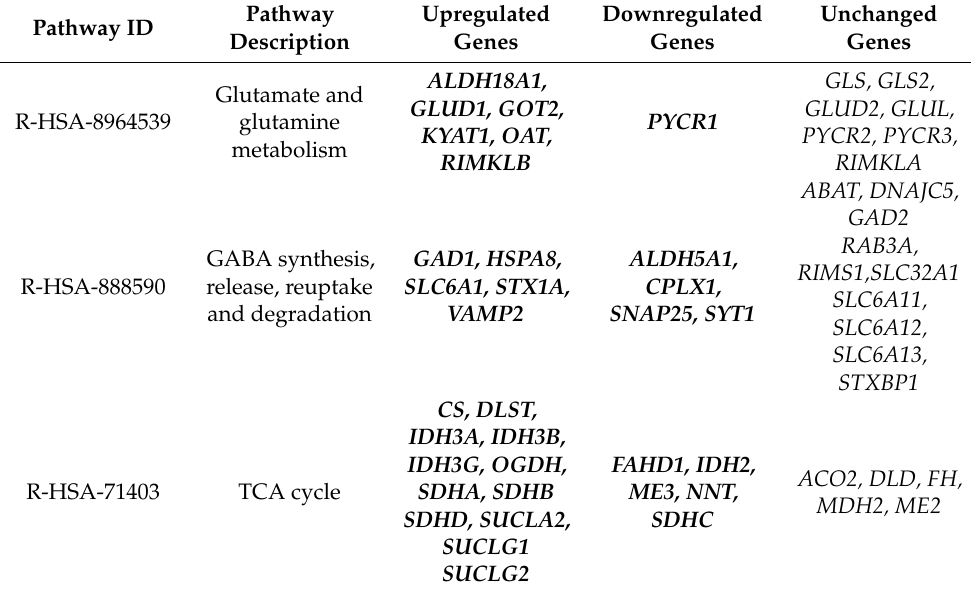
Table 1. Functional classification analysis of repressed or overexpressed genes in MELAS cells according to the REACTOME pathway